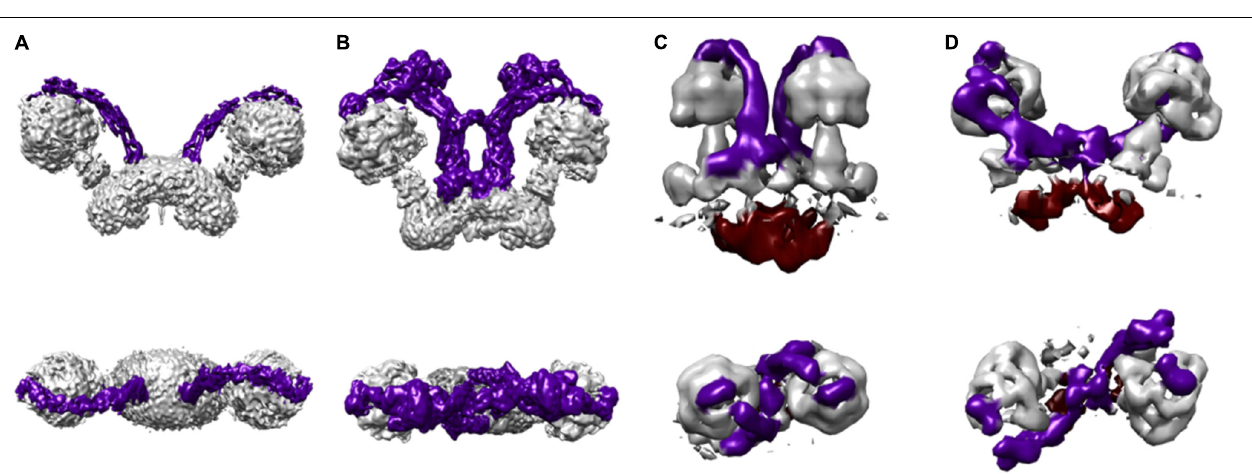
FIGURE 3 | Working model of the dimeric mitochondrial ATPase of Polytomella sp. The image shows the working model of the 3D structure of the enzyme fitted in the EMD-2852 map contoured at 6 sigma (Allegretti et al., 2015). Color scheme: F 1 sector in pink; OSCP in violet; Asa2 in cyan; Asa4 in deep purple; Asa7 in sky blue; Asa1 in yellow; Asa3 in brown (dirty violet); Asa5 in salmon; Asa6 in gray; Asa8 in orange; Asa9 in leaf green; subunit a in deep teal and c -ring in pale cyan.